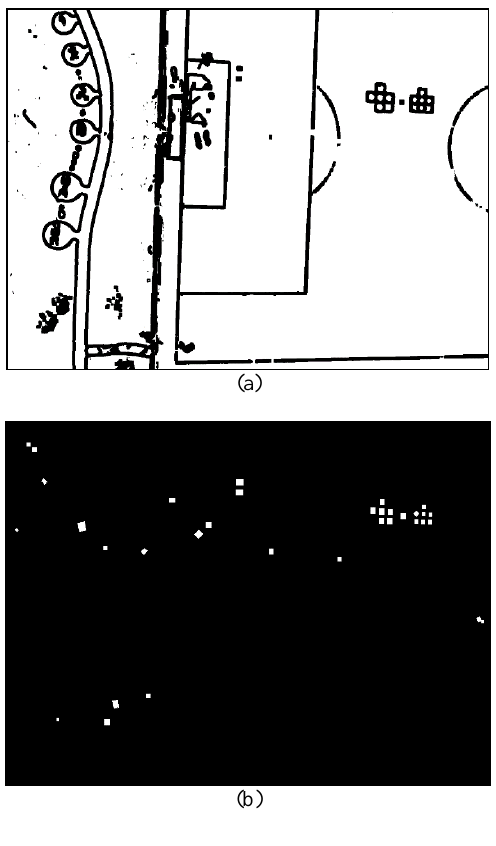
Figure 7. Automatic target detect